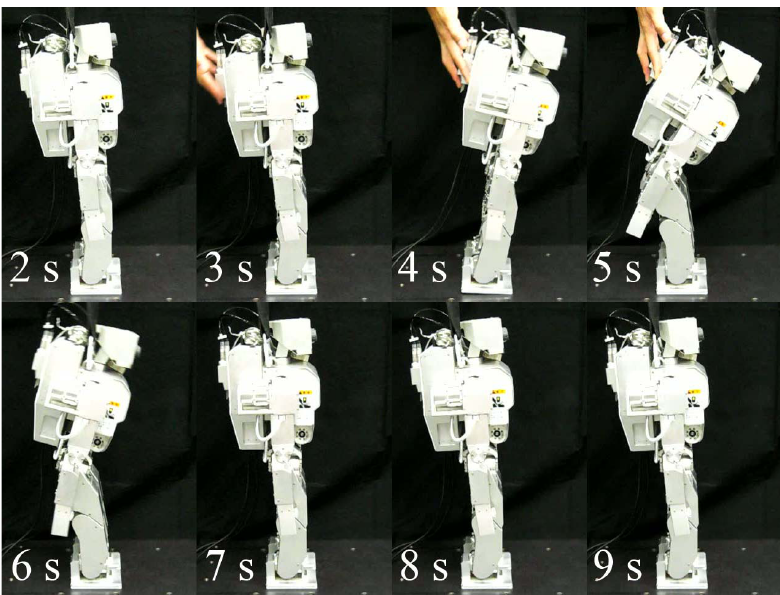
Figure 11. Snapshots from the experiment with a HOAP-2 robot responding to an unknown continuous-force disturbance on the back (sagittal plane). The so-called Hip strategy has been realized under velocity-based reactionless motion with a three-link two-joint model in the sagittal plane (Nenchev and Nishio, 2008; Kanamiya et al.,